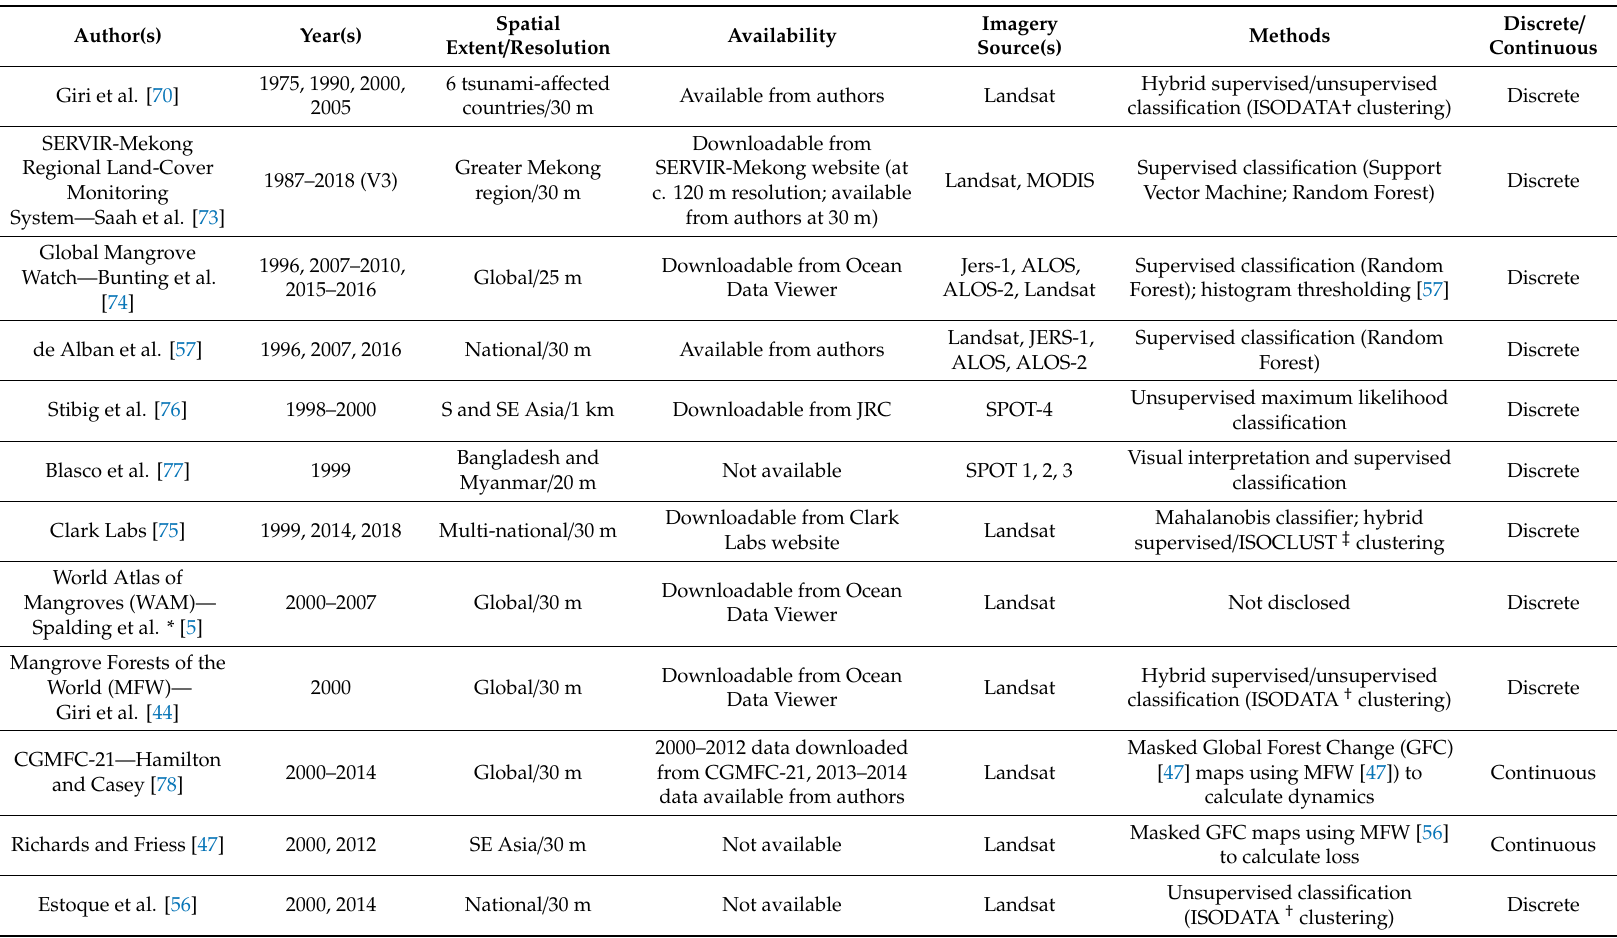
Table 1. Inventory and summary of existing national-level mangrove datasets for Myanmar—July